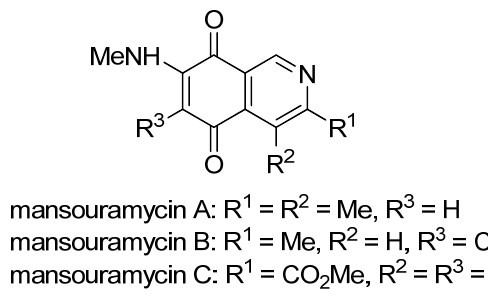
Figure 1. Structure of caulibugulones A–D and mansouramycins